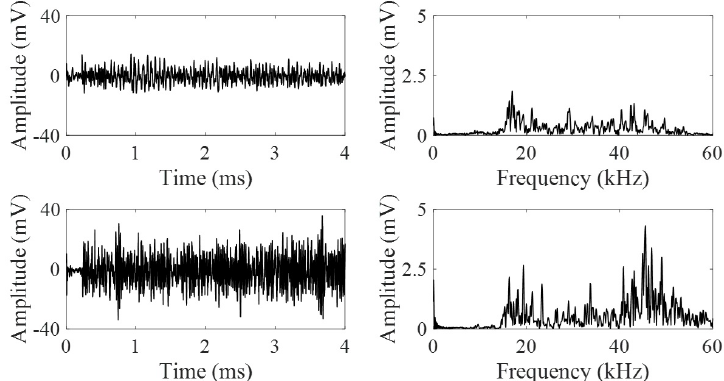
Figure 10. ( a ) Leak waveforms at 30 psi internal pressure in time and frequency domains with lens, ( b ) without